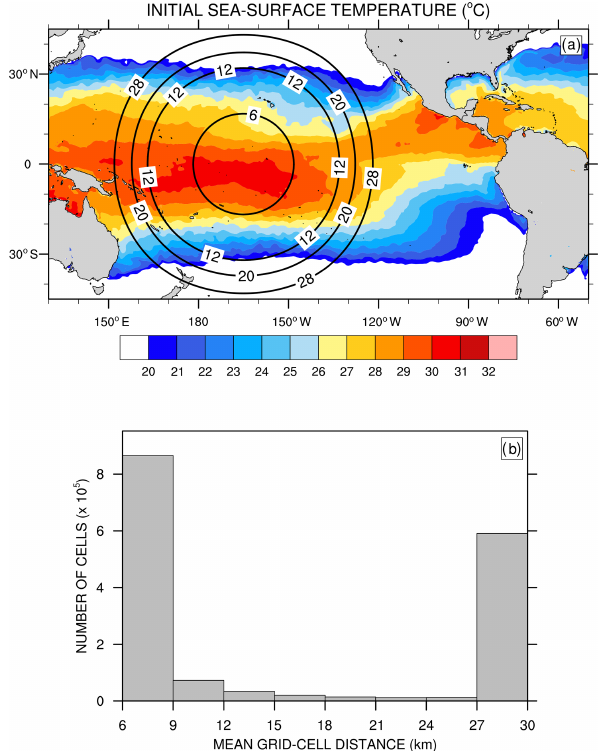
Figure 2. (a) Initial sea-surface temperature and refined variable- resolution mesh depicted using isolines of the mean distance be- tween grid-cell centers (km) over the tropical Pacific Ocean; and (b) histogram of the number of cells as a function of the mean dis- tance between grid-cell